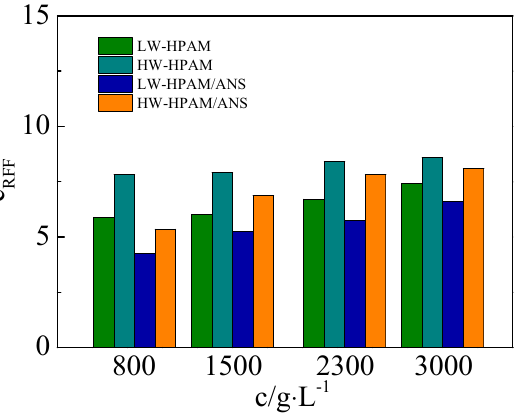
Figure 14. Critical point (c RFF ) of the injection ability for injection systems at different polymer concentrations. c ANS = 3.0 g · L − 1 .